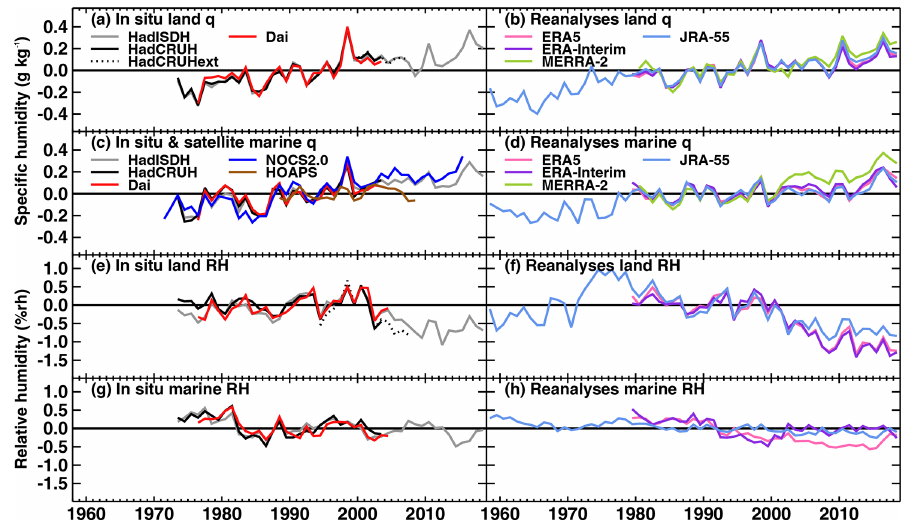
Figure 1. Global-average surface humidity annual anomalies (base period: 1979–2003). For in situ datasets, 2m surface humidity is used over land and ∼ 10m over the oceans. For the reanalysis, 2m humidity is used across the globe. For ERA-Interim and ERA5, ocean-only points over open sea are selected, and background forecast values are used as opposed to analysis values to avoid incorporating biases from unadjusted ship data. All data have been given a mean of 0 over the common period 1979–2003 to allow direct comparison, with HOAPS given a mean of 0 over the 1988–2003 period. (Sources: HadISDH – Willett et al., 2013, 2014; HadCRUH – Willett et al., 2008; Dai – Dai, 2006; HadCRUHext – Simmons et al., 2010; NOCSv2.0 – Berry and Kent, 2009, 2011; HOAPS – Fennig et al., 2012; ERA-Interim – Dee et al., 2011; ERA5 – C3S, 2017; Hersbach et al., 2020; MERRA-2 – Gelaro et al., 2017; Bosilovich et al., 2015; JRA-55 – Kobayashi et al., 2015). Adapted from Willett et al.